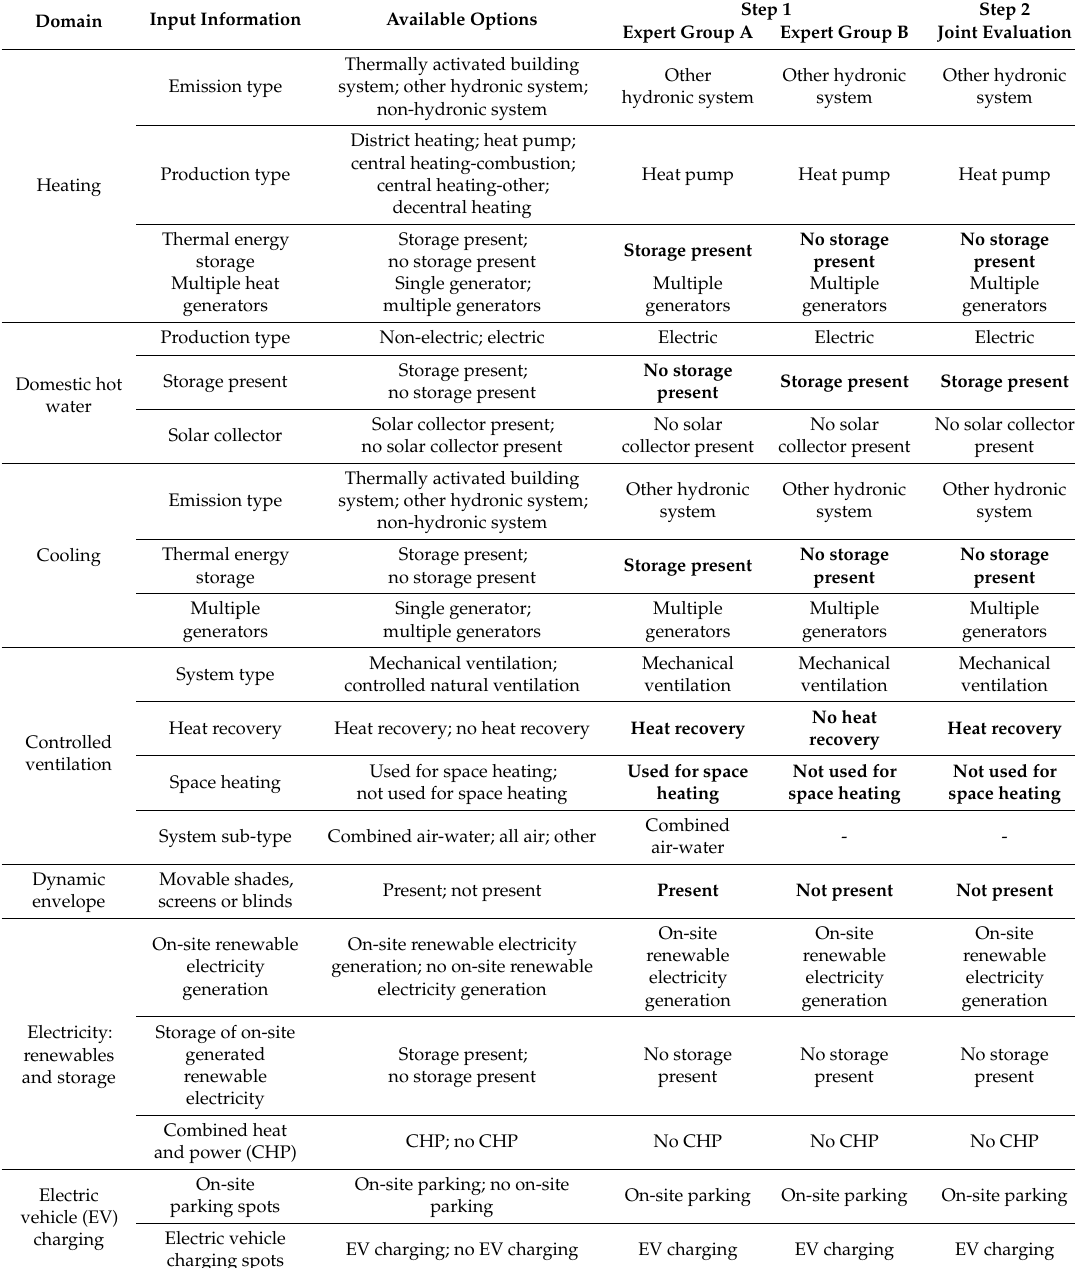
Table 3. Excel-based calculation tool. Choice of input information in the triage process (in bold in the table when assessed di ff erently) to indicate the available building systems in the case